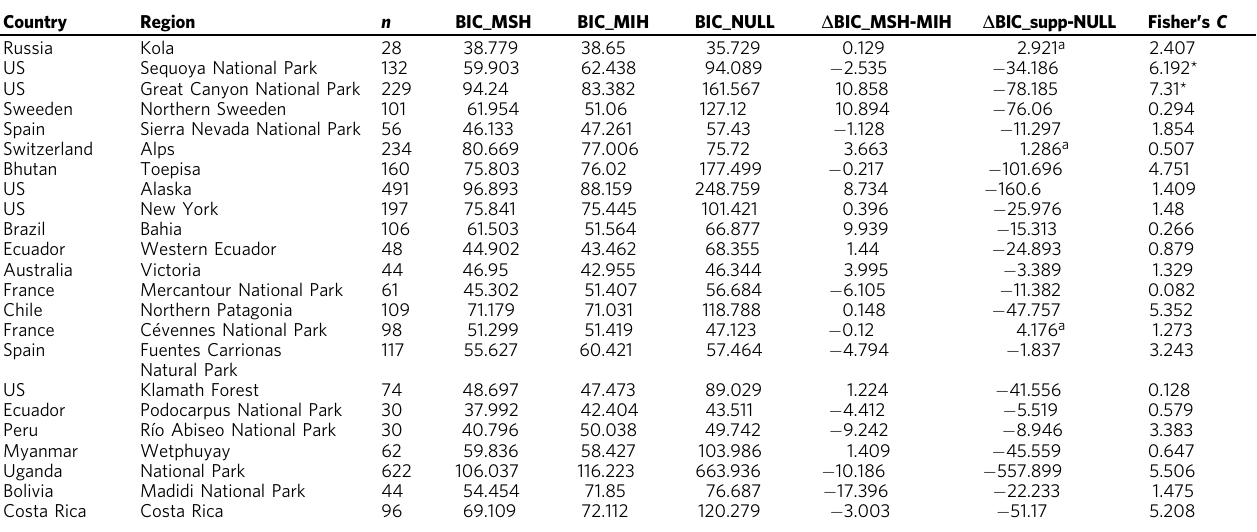
Table 1 Diversity effects were only supported in six forest regions. Country